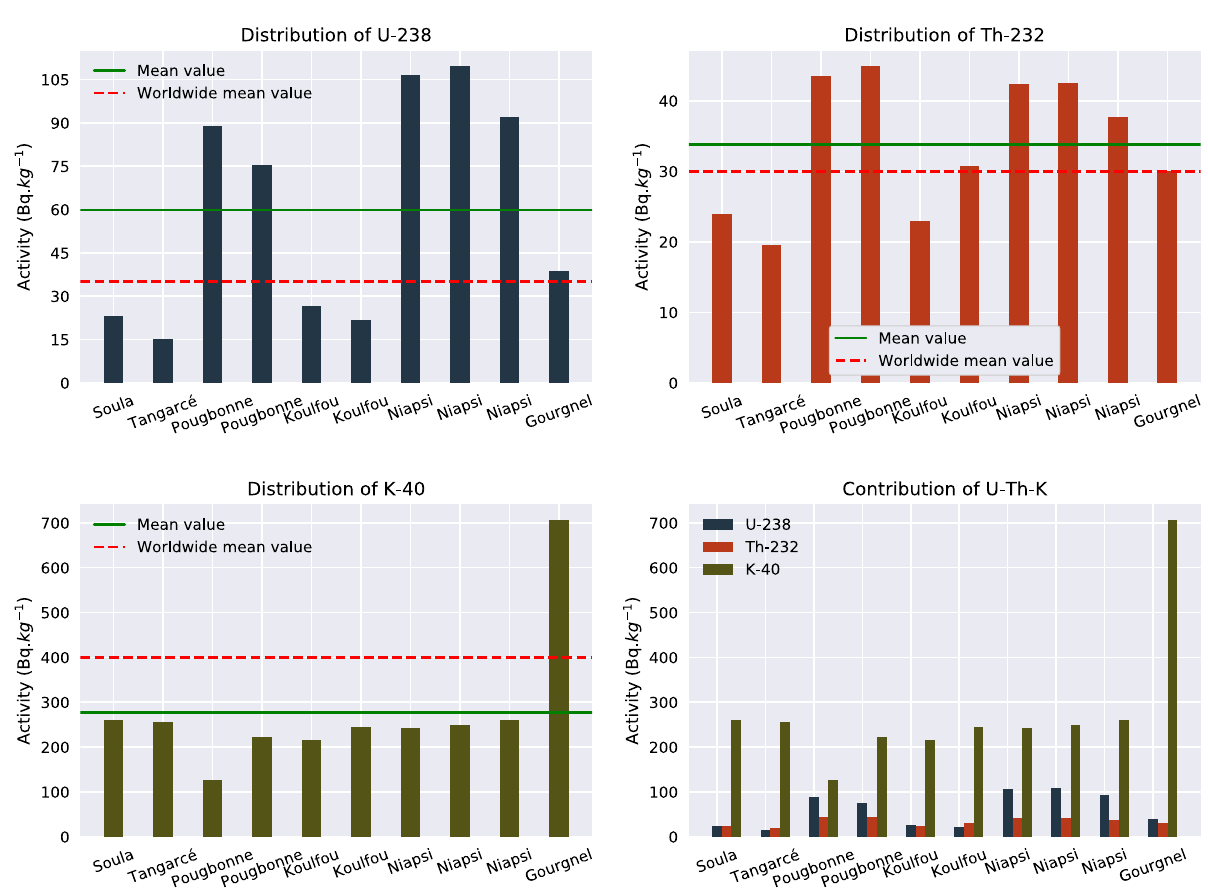
Fig. 2 Distribution of 238 U , 232 Th and 40 K activity concentrations for a depth of 20 cm